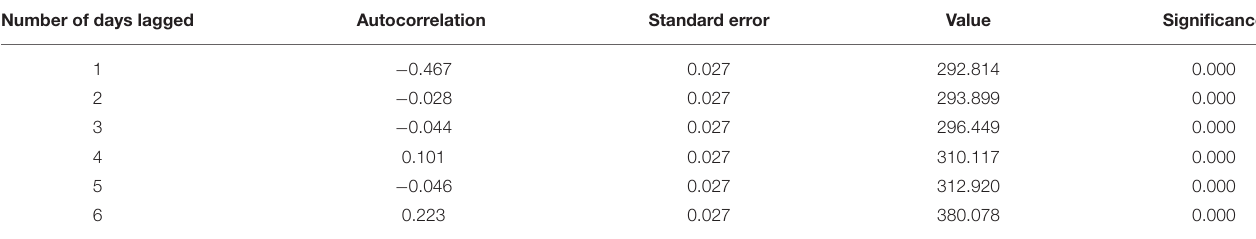
TABLE 4 | Autocorrelation analysis of the time series of the air quality and risk of emergency room visits for patients with atrial fibrillation. Number of days